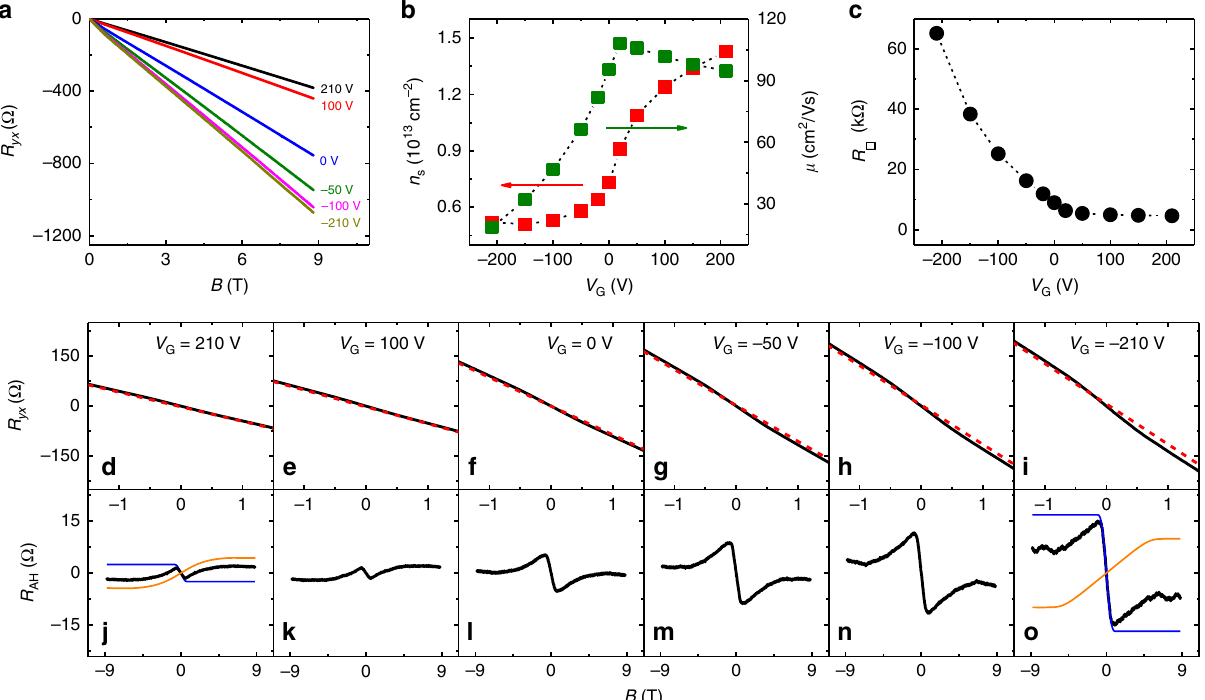
Fig. 4 Gate-voltage tuning of the anomalous Hall effect in a (Bi 1 − x Mn x ) 2 Se 3 thin fi lm ( x = 0.074). a R □ curves at V G = + 210 to − 210 V. b Gate-voltage dependence of n s (red square) and μ (green square). c Gate-voltage dependence of R □ . d – i Magnetic fi eld dependences of R yx for gate voltages from 210 to – i . For V = ±210 V, the positive (orange) and negative − 210 V. j – o Magnetic fi eld dependences of R AH for the same range of gate voltages as panels d G (blue) AH components separated from the total R AH are also shown. The Hall effect data were taken from Sample F at T = 1.6